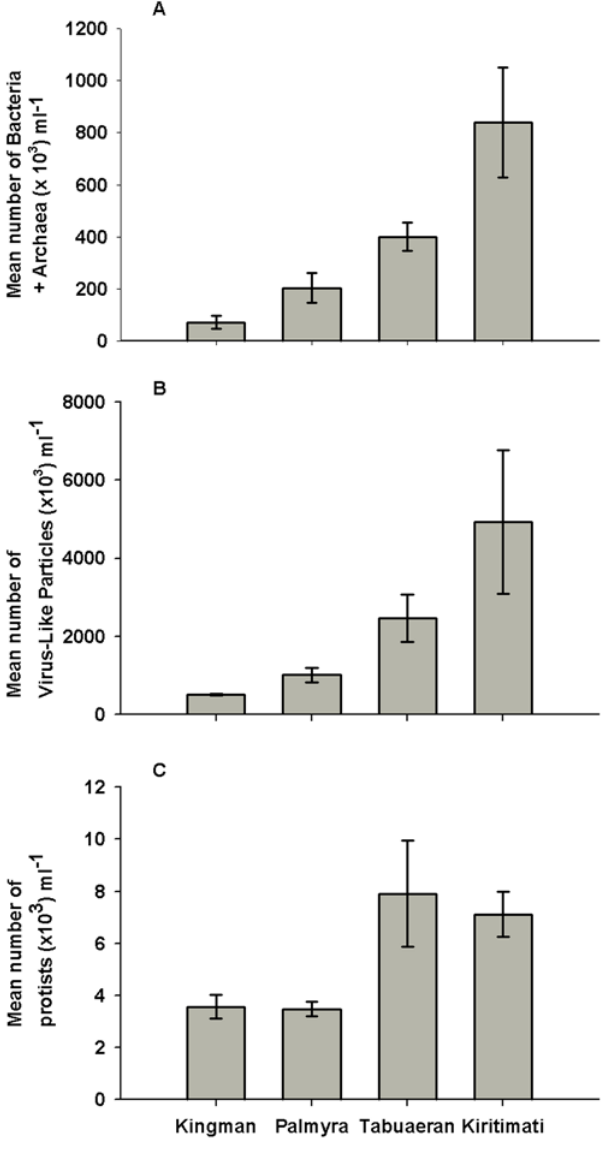
Figure 2. Direct counts were used to determine the mean abundance ( 6 standard error) of A) microbial cells (Bacteria and Archaea), B) virus-like particles (VLPs), and C) protists on the four Northern Line Island